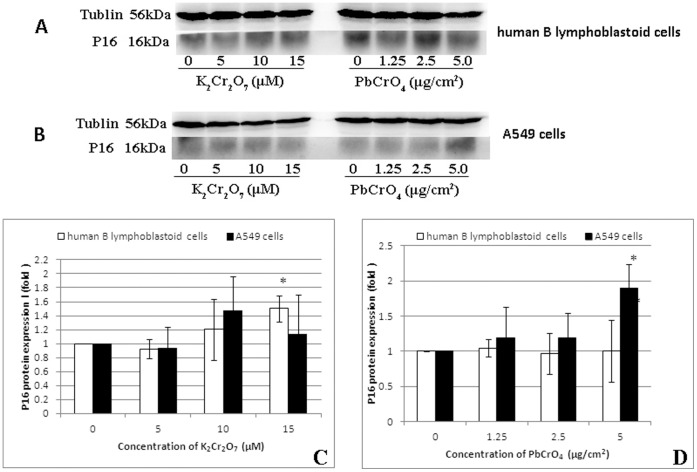
Protein expression of p16 gene.Human B lymphoblastoid cells and A549 cells were exposed to potassium dichromate or lead chromate for 24 hours, and p16 protein expression was analyzed by western blot with 100 µg of protein. A–B: Western blots of p16 and tublin in human B lymphoblastoid cells (A) and A549 cells (B). C–D: Histograms of Integrated Density Value for each protein in human B lymphoblastoid cells (C) and A549 cells (D), normalized to tublin. Asterisks above the bars indicate that the difference between exposure and control was significant (P<0.05).